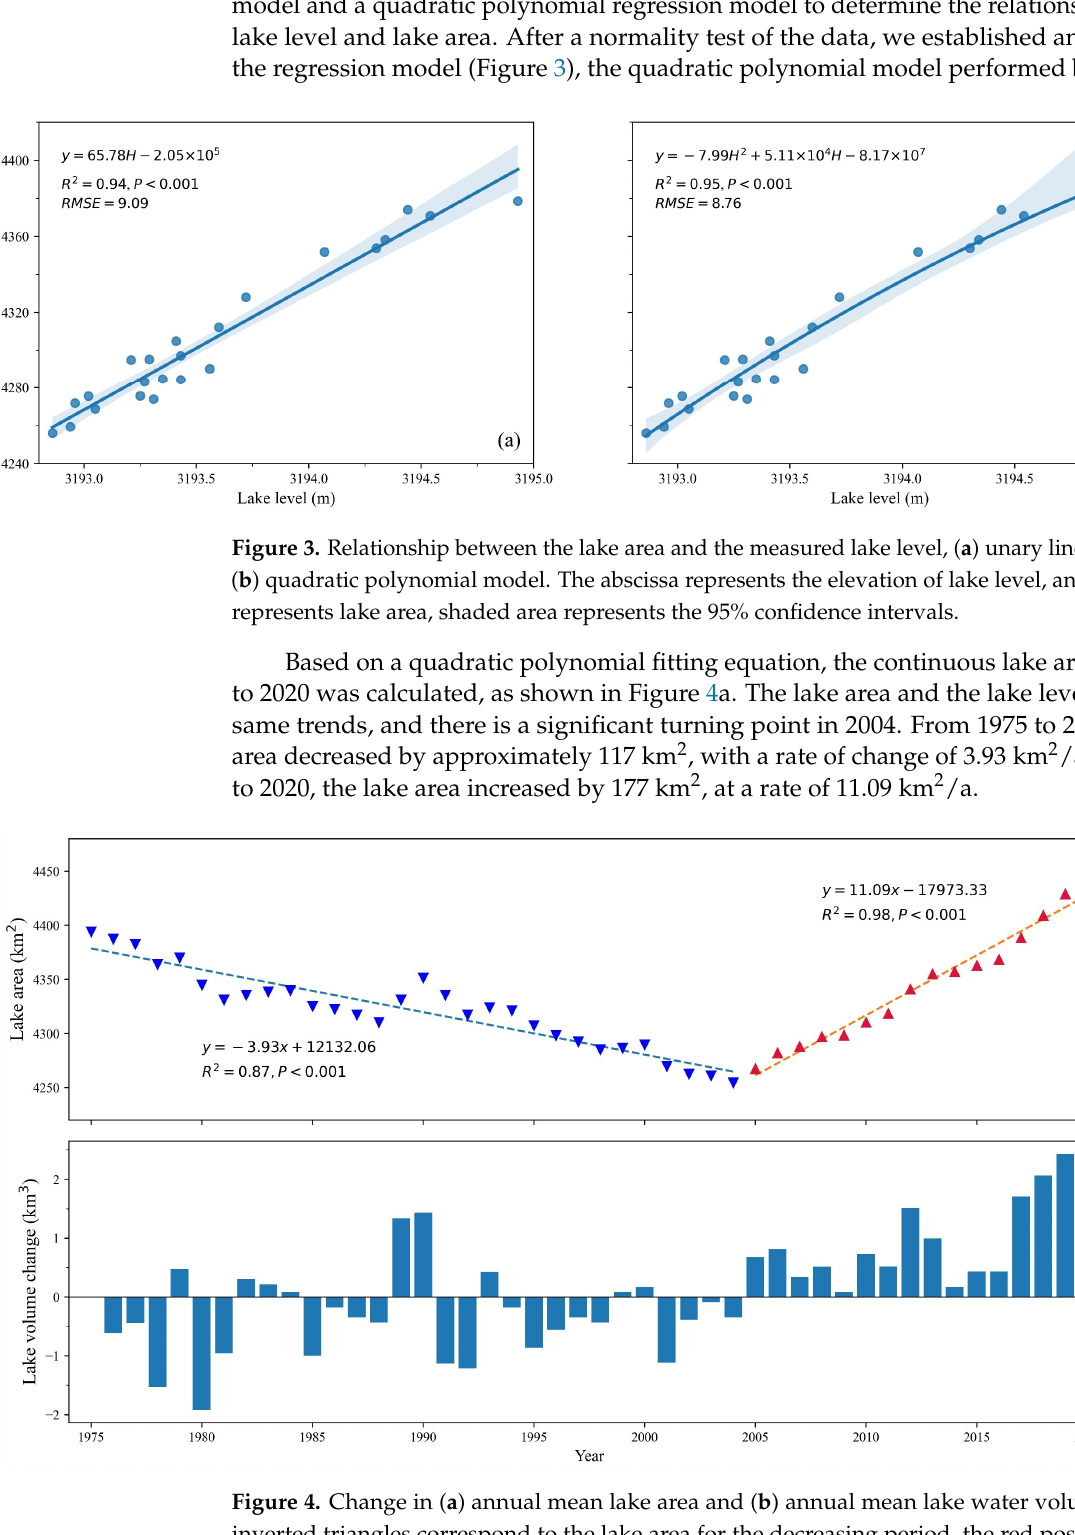
Figure 4. Change in ( a ) annual mean lake area and ( b ) annual mean lake water volume. The blue inverted triangles correspond to the lake area for the decreasing period, the red positive triangles